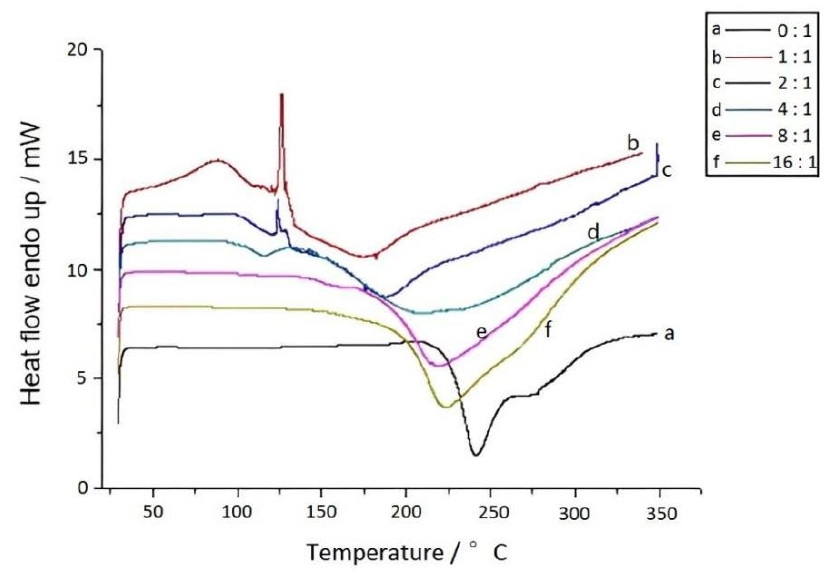
Figure 18. DSC curve of benzoxazine (cardanol) with different content of OMPS.